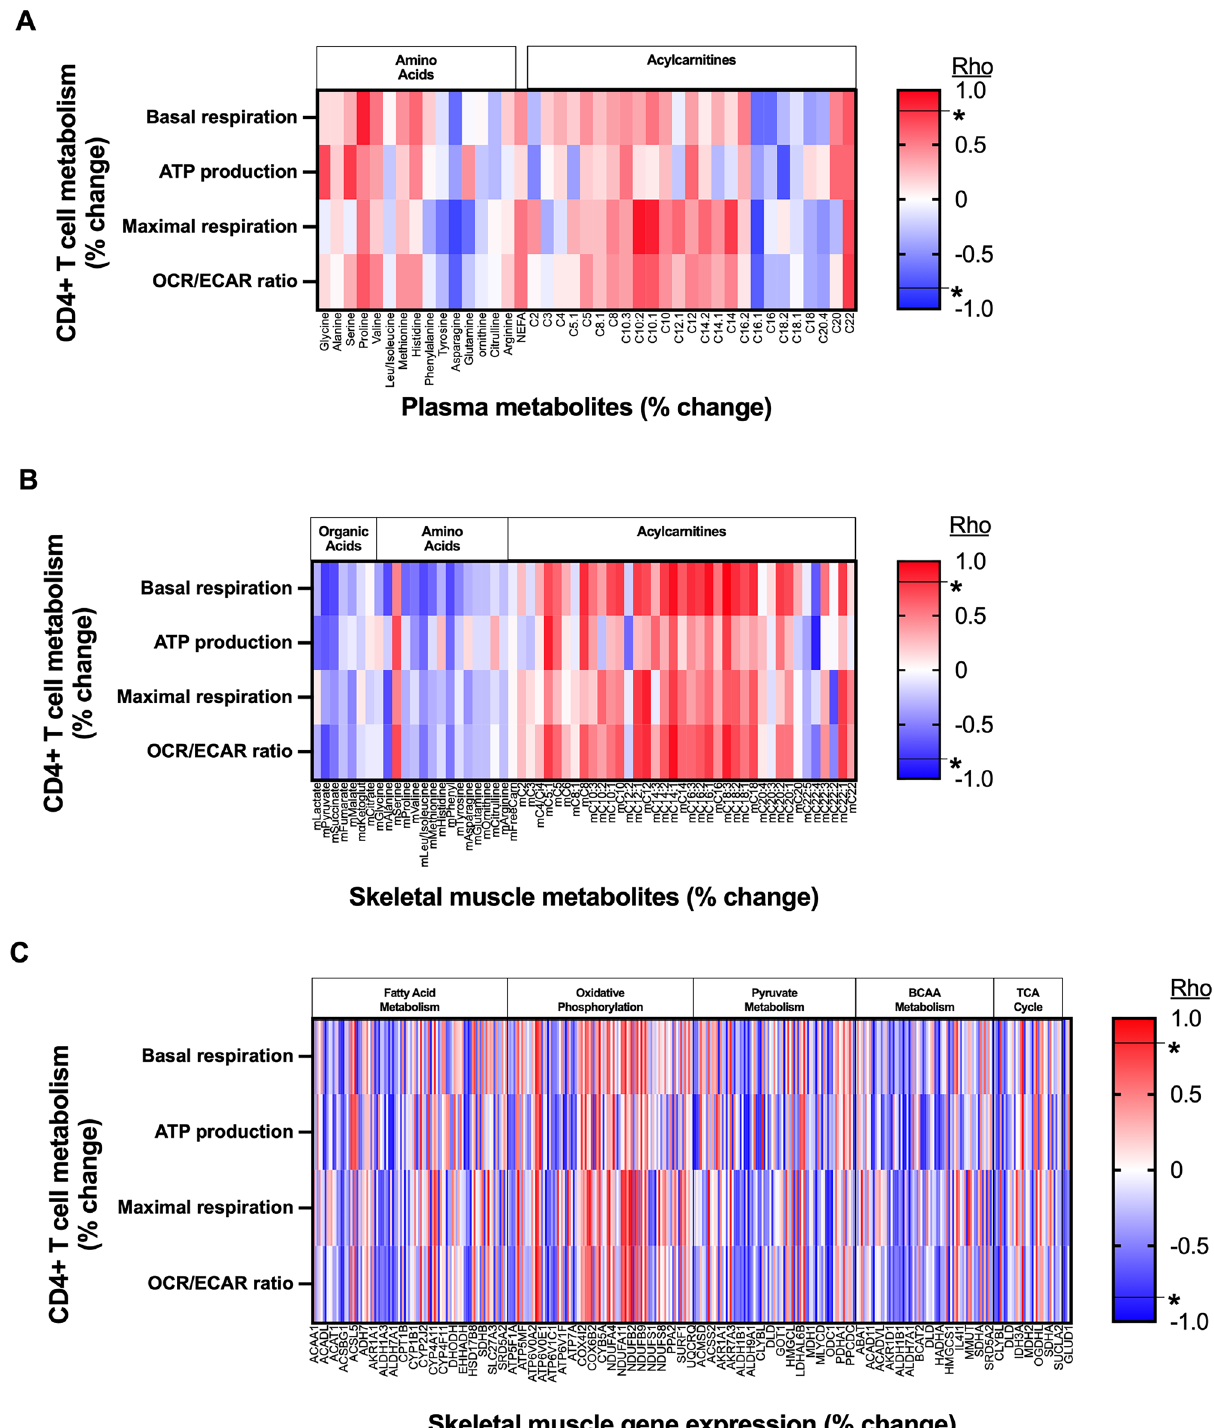
Figure 4. Changes in RA T cell respiration associate with changes in skeletal muscle acylcarnitine concentrations and increases in oxidative metabolism gene transcripts. ( A ) Heat map depicts correlations (Spearman’s rho) between percent change in rheumatoid arthritis (RA) peripheral CD4 + T cell respiration with plasma metabolites following high-intensity interval training (HIIT) (subgroup n = 6). ( B ) Heat map depicts correlations between percent change in RA peripheral CD4 + T cell respiration with skeletal muscle metabolites following HIIT (subgroup n = 6). ( C ) Heat map depicts correlations between percent change in RA peripheral CD4 + T cell respiration with skeletal muscle RNA with molecular relationships to carnitine acetyltransferase pathways (subgroup n = 6). * p < 0.05 (without multiple testing correction) for −0.8 ≤ rho ≤ 0.8. m Muscle, C